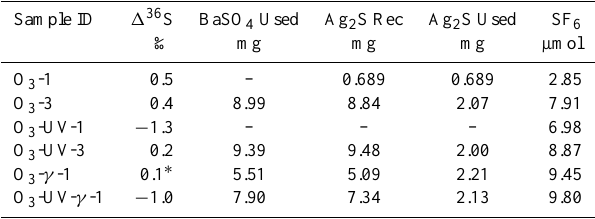
Table A1. Isotopic composition of samples. The table displays the sample ID, 1 36 S (normalized against the references as defined in Appendix B), the mass of BaSO 4 used, the mass of Ag 2 S recovered, the mass of Ag 2 S used, and the amount of SF 6